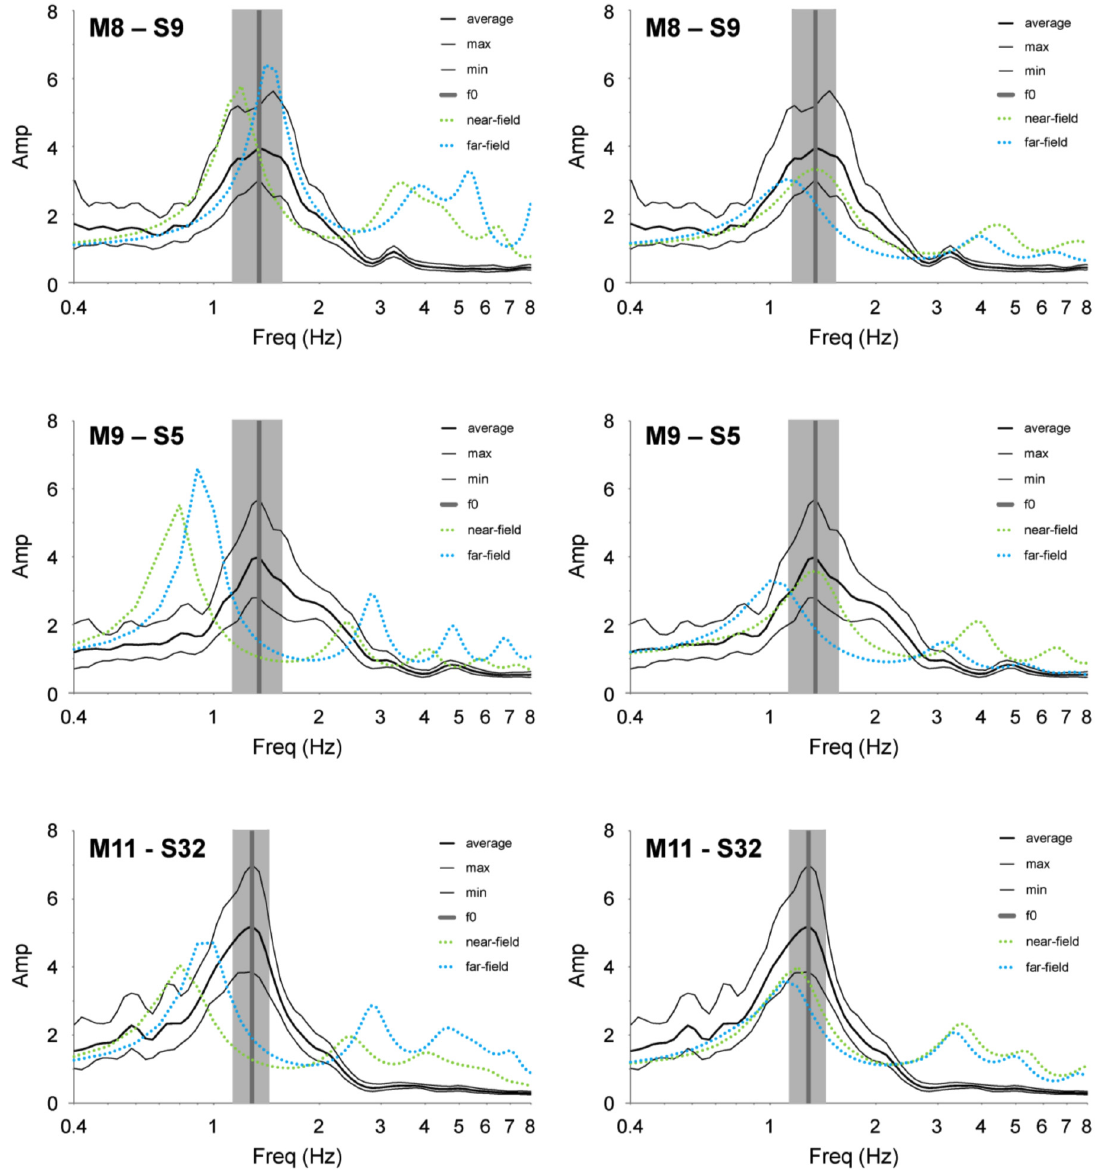
Figure 12. Comparison between the computed transfer functions and the H/V curves obtained from ambient vibration analysis. Left: trans- fer functions computed with the first estimated V values. Right: transfer functions computed with the final estimated V S